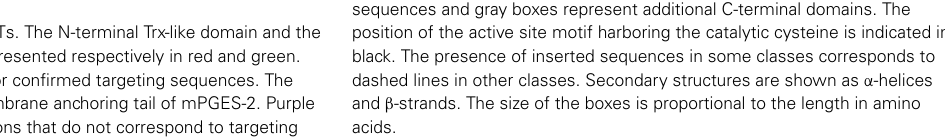
FIGURE 3 | Continued protein architecture of plant Cys-GSTs. The N-terminal Trx-like domain and the all-helical C-terminal domain are represented respectively in red and green. Blue boxes correspond to putative or confirmed targeting sequences. The orange box corresponds to the membrane anchoring tail of mPGES-2. Purple boxes represent N-terminal extensions that do not correspond to targeting